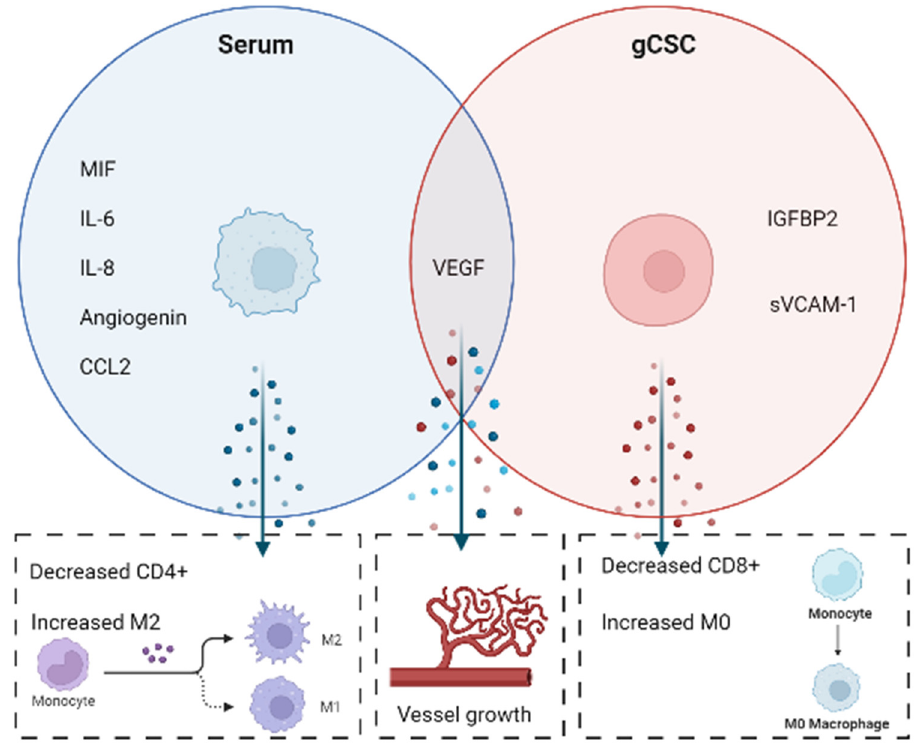
Figure 8. Serum-derived and gCSC cell secreted immune-modulators. Shown are molecules found to be secreted by either serum-derived or gCSC cells, and the associated modulatory role within glioblastoma microenvironments. Figure based on secretome analysis, CIBERSORT, and relevant literature represented in Figure 1 and Table